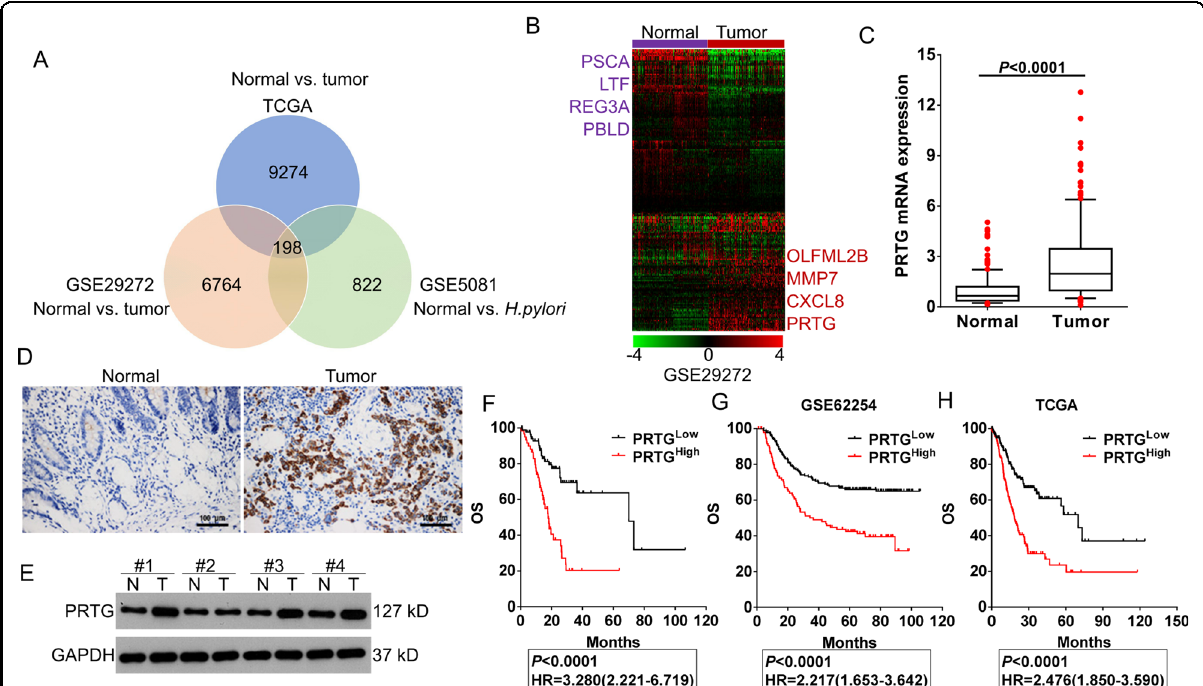
Fig. 1 PRTG is upregulated in both gastric cancer and H. pylori -infected tissues. A Venn diagram of genes showing signi fi cant differential expression between normal and cancer tissues in two Gastric cancer patient cohorts (TCGA, GSE29272), as well as differential genes between normal and H. pylori -infected tissues in dataset GSE5081. B A heat map of the 198 differentially expressed genes of Fig. 1A in the GEO dataset GSE29272. Eight top-ranked genes were highlighted in purple or red text. C PRTG expression was examined by qRT-PCR in local 152 human gastric cancer tissues compared with normal tissues. Boxes represent medians and interquartile ranges, with whiskers indicating 10% to 90% range. Dots represent patients who fell outside the 10% to 90% range. D IHC was used to detect the expression level of PRTG in gastric cancer and adjacent normal tissues. E western blot analysis of the expression level of PRTG in in gastric cancer and adjacent normal tissues. F – H Kaplan – Meier survival plots analysis of the overall survival for 152 gastric cancer patients in local hospital ( F ), GEO dataset GSE62254 ( G ) and TCGA ( H ) with high or low PRTG